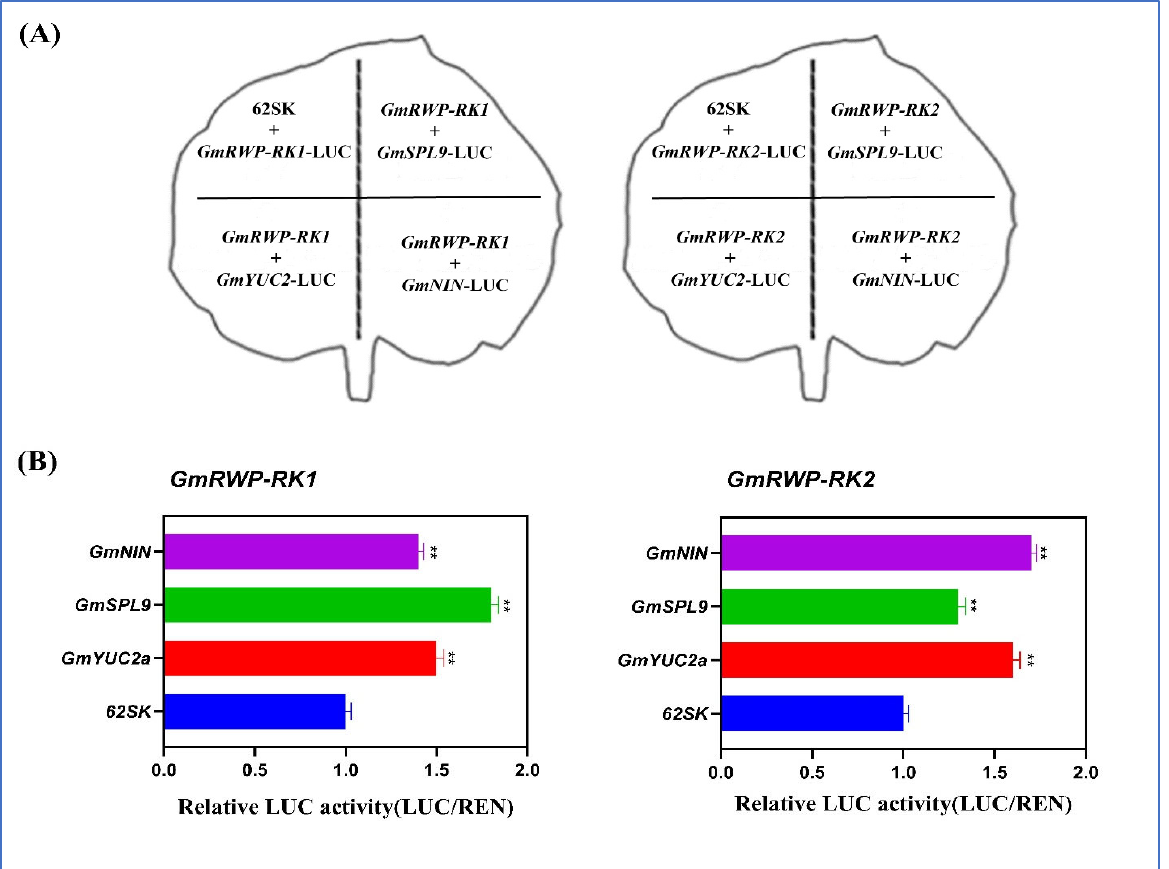
Figure 12. Split ‐ luciferase complementation assay demonstrating the active interaction of GmRWP ‐ RK1 and GmRWP ‐ RK2 with GmYUC2 , GmSPL9 , and GmNIN in tobacco leaves. ( A ) Demonstrates the graphical representation of LUC/gene, LUC/62SK reporter genes with GmRWP ‐ RK1 and GmRWP ‐ RK2 with GmYUC2 , GmSPL9 , and GmNIN ( B ) Demonstrates the relative luciferase activity of the reporter and effector genes, respectively. Error bars shows the standard deviation between samples and asterisks represents ** significant difference at p < 0.01.